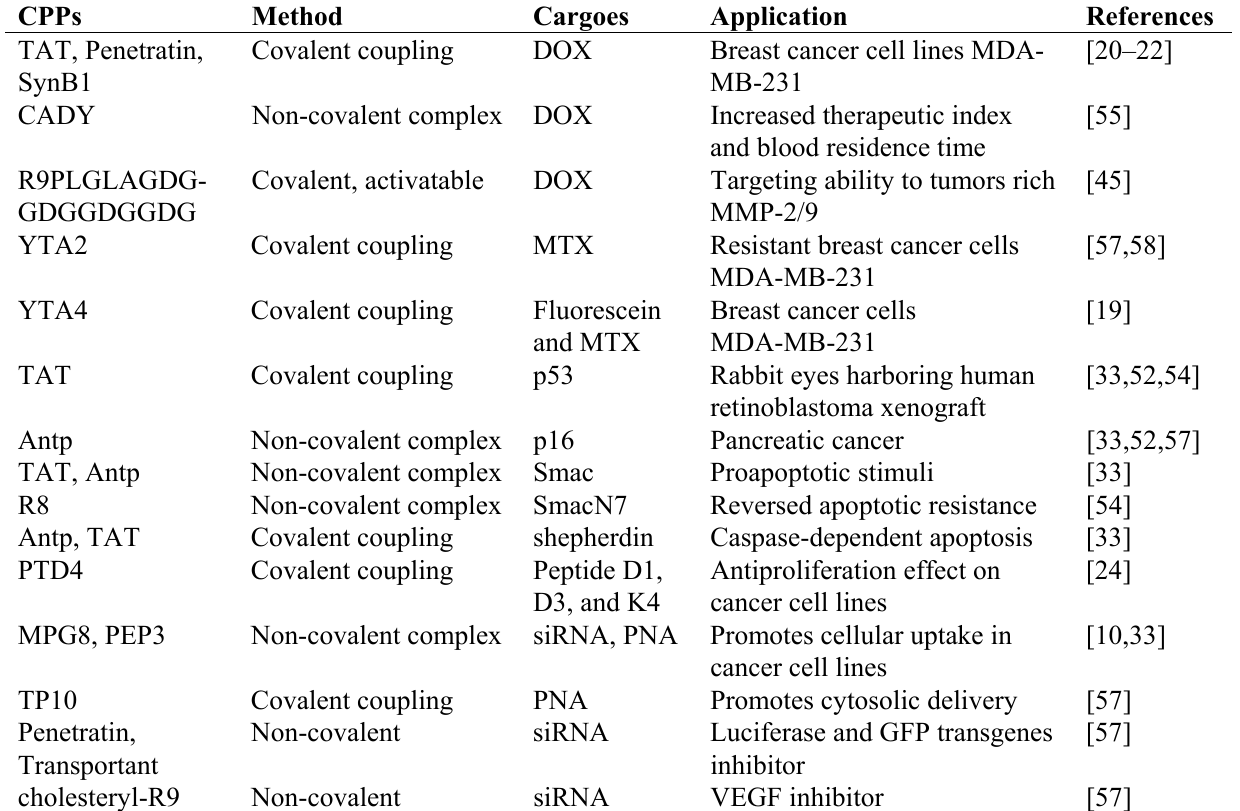
Table 3. Examples of CPPs and drug cargoes for tumor